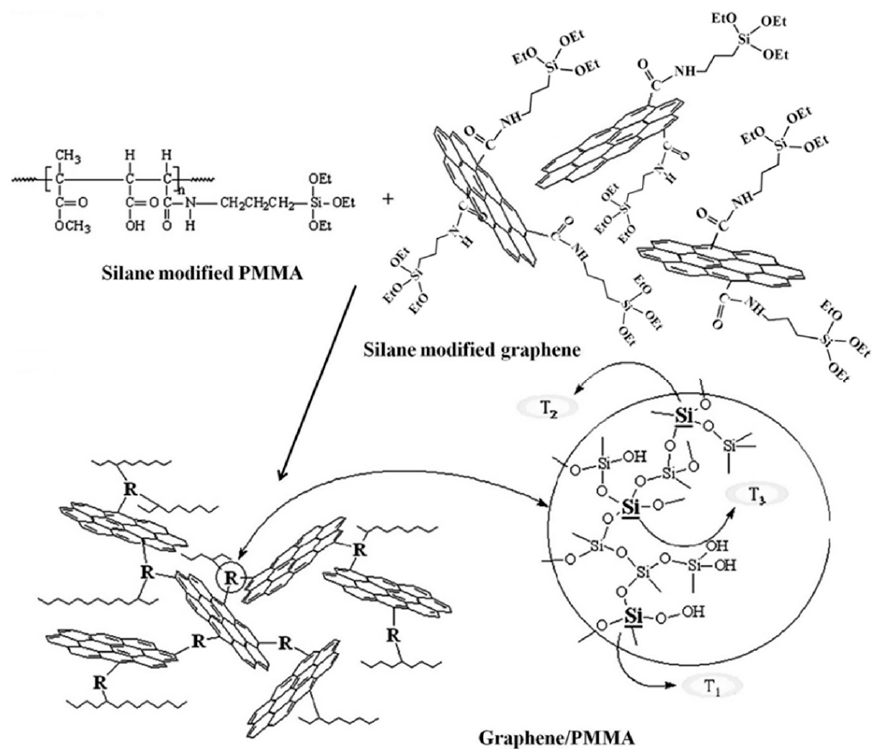
Figure 8. Schematic showing the use of the sol–gel method to prepare functionalized graphene/PMMA composites. Reprinted with permission from [86]. 2012, Mater. Chem. Phys.